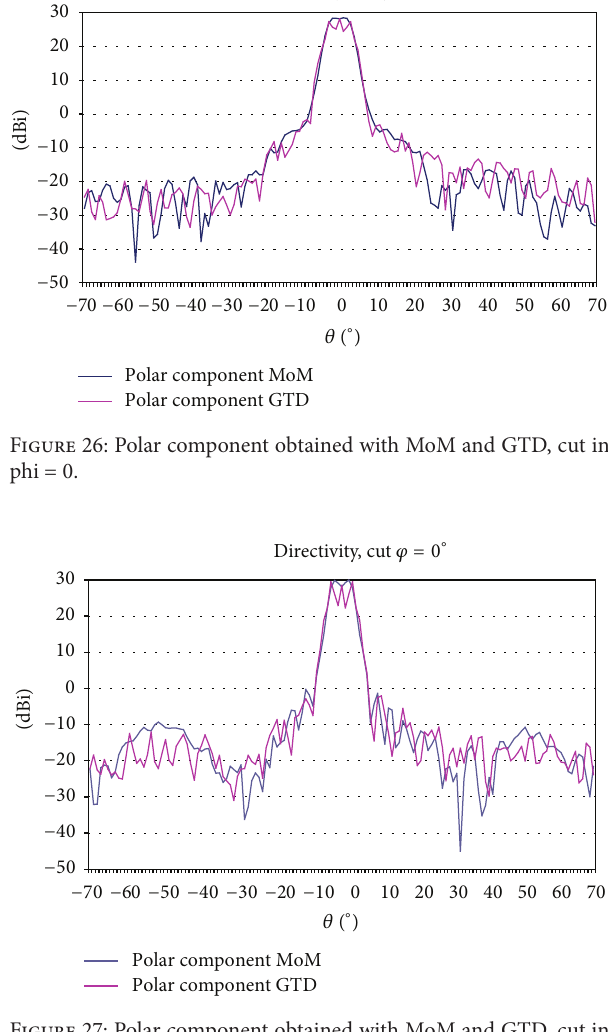
Figure 27: Polar component obtained with MoM and GTD, cut in phi = 90 ∘